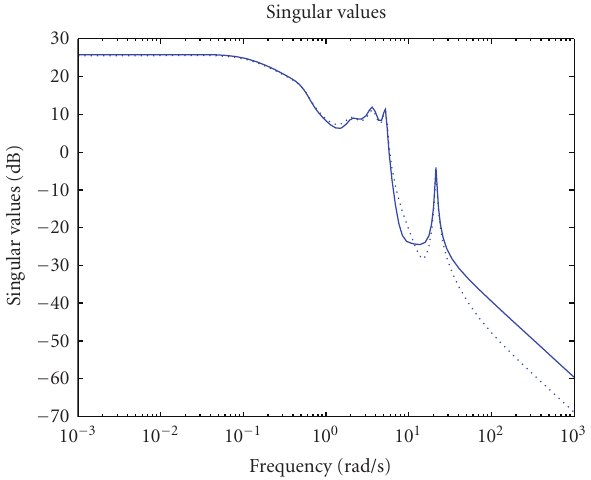
Figure 11: The infinity norm of original of transfer matrix of second subsystem (solid line) and its reduced-order counterpart of order 19 (dotted) over frequency domain [ ω 1 , ω 2 ] = [0 .